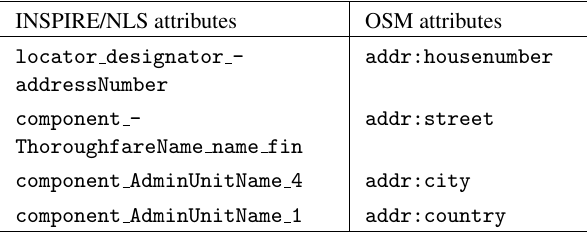
Table 3: Mapping between attribute names of the INSPIRE/NLS and the OSM data models related to addresses used in this